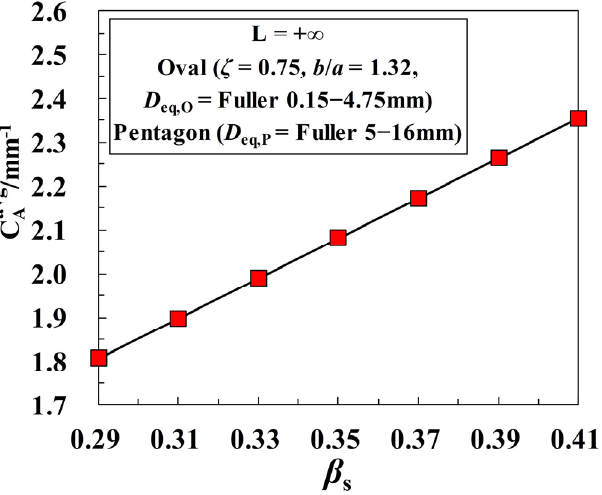
Figure 13. Effect of the sand ratio β s on the average specific surface area of particles for the cases in Figure 12.